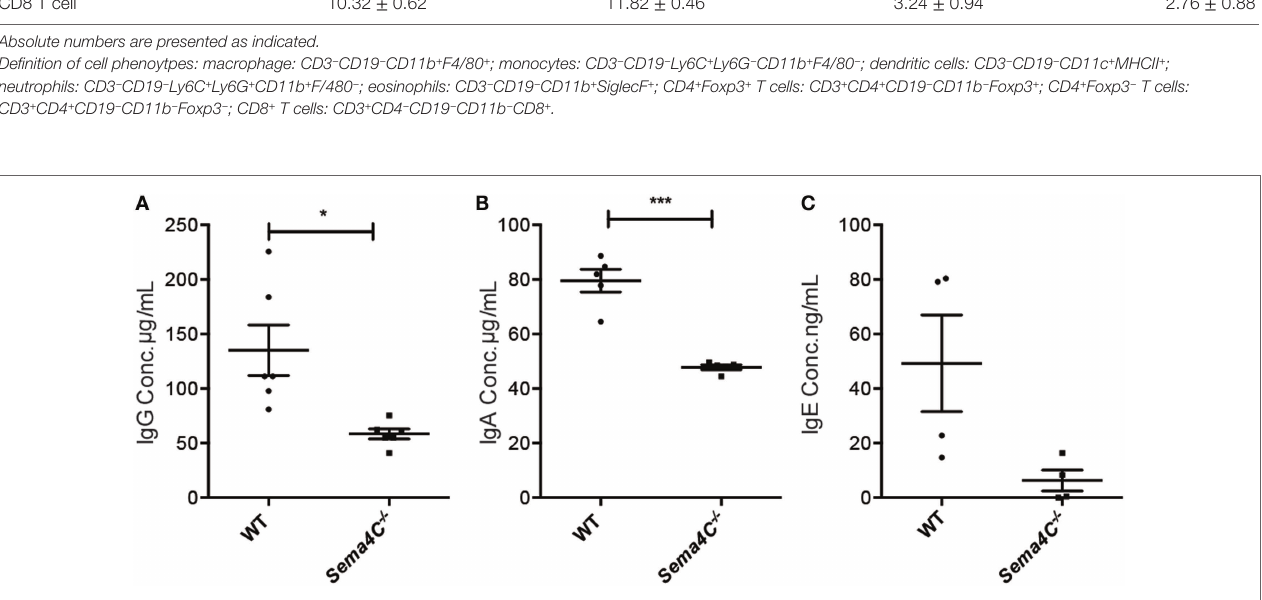
FigUre 3 | sema4c − / − mice demonstrate impaired in vitro immunoglobulin production . Splenic B-cells were isolated from WT and Sema4C − / − mice, then stimulated with anti-CD40 antibodies in the presence of IL-4 and IL-21, at the density of 10 6 cells/mL. IgG (a) and IgA (B) concentrations in the supernatant were measured after 4 days of culture by ELISA. IgE (c) concentrations were similarly measured by ELISA after 7 days of culture. Means ± SEM, three independent experiments. Each dot represents one individual mouse. * p < 0.05, *** p < 0.001.